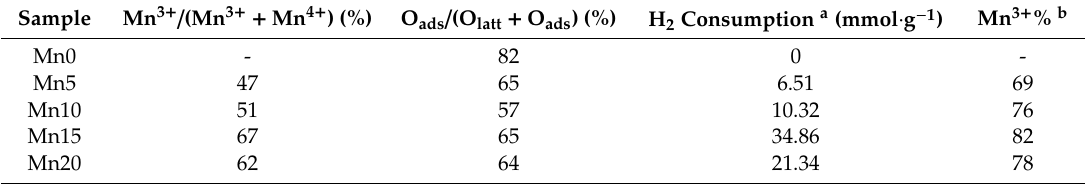
Table 3. X-ray photoelectron spectroscopy (XPS) and H 2 -TPR results of